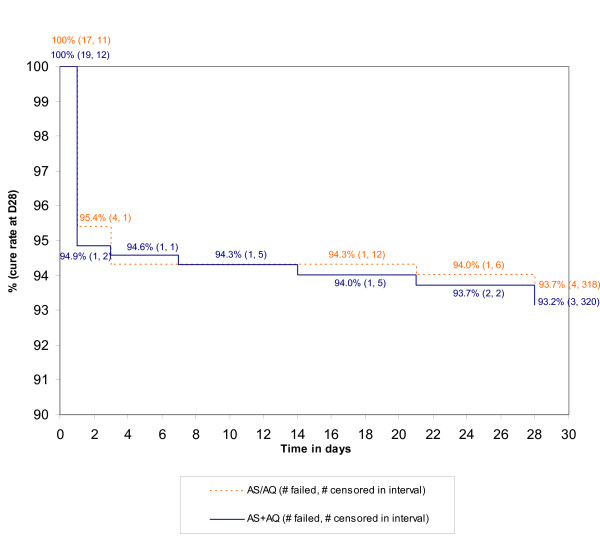
Kaplan Meier survival efficacy analysis of all randomized patients. Rates are expressed as 1 minus the rate of parasitological failure.